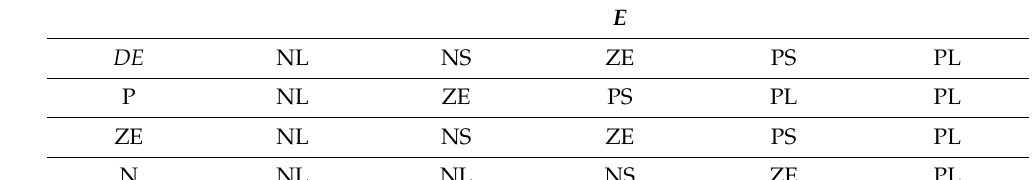
Figure 4. Fuzzy PD logic controller membership functions (N: negative, ZE: zero, P: positive, L: large, S: small). Table 1. Rules matrix of the fuzzy PD logic controller.